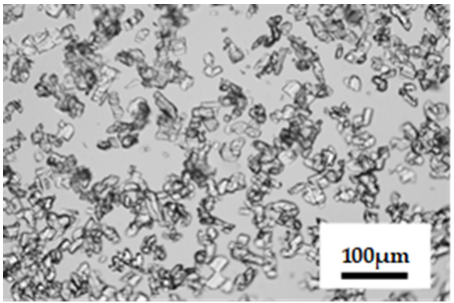
Figure 3. Optical micrograph of crystals obtained using cooling crystallization based on the aqueous